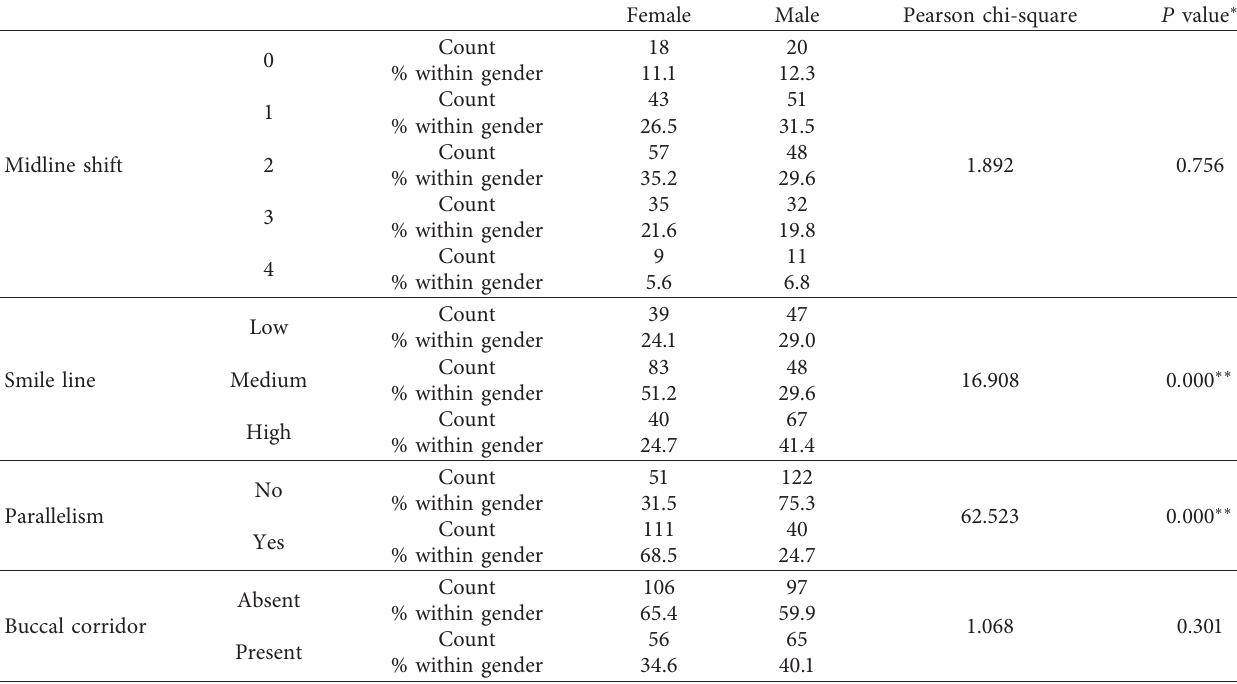
Table 2: Chi-square test for the association between gender and different smile